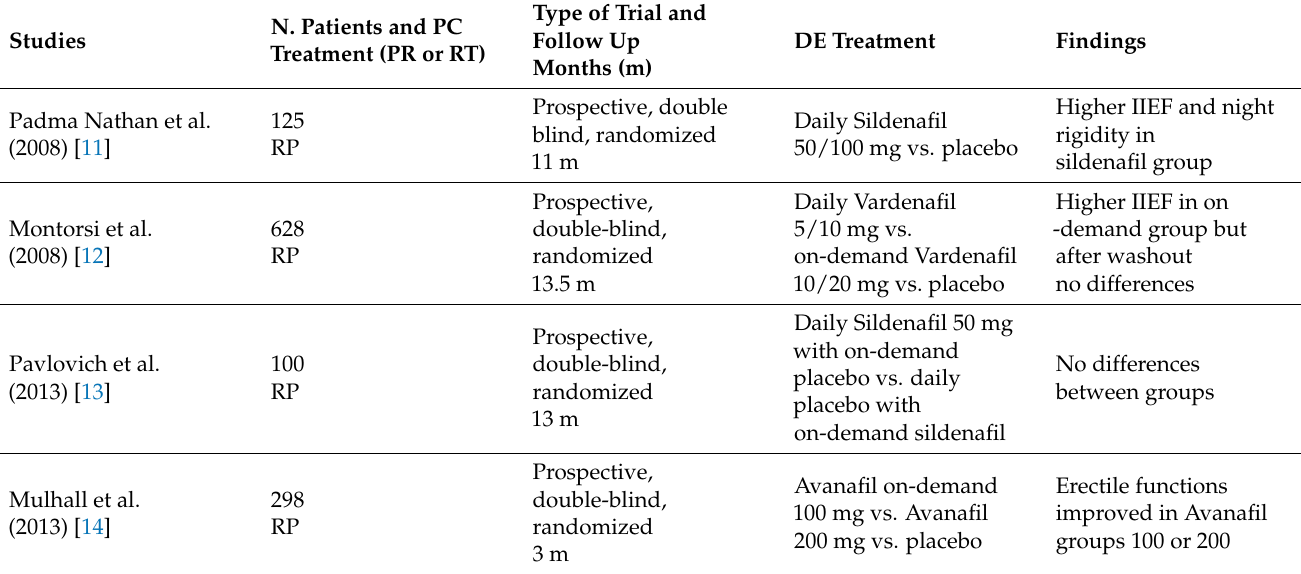
Table 1. Studies that have investigated the role of PDEI-5 after RP or RT in EF after primary